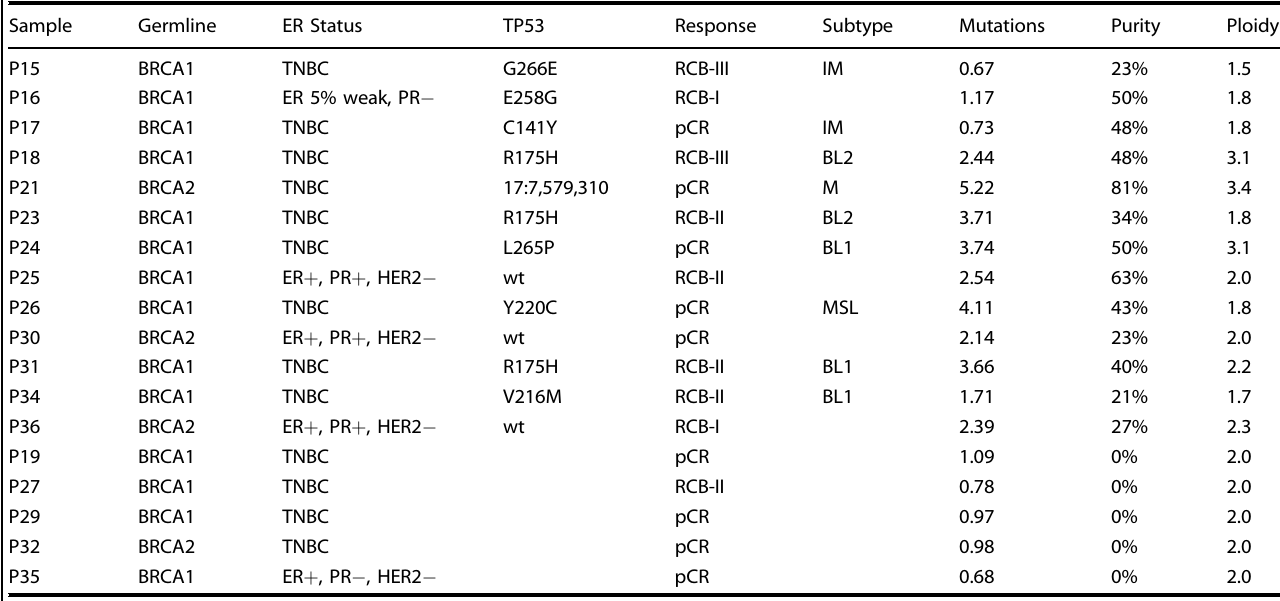
Table 1. Description of